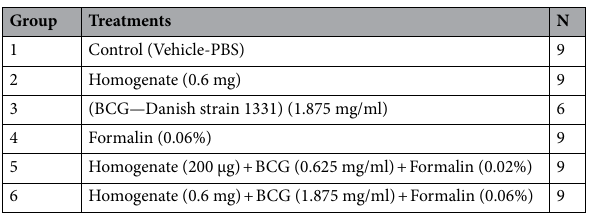
Table 1. Treatments administered for each group of